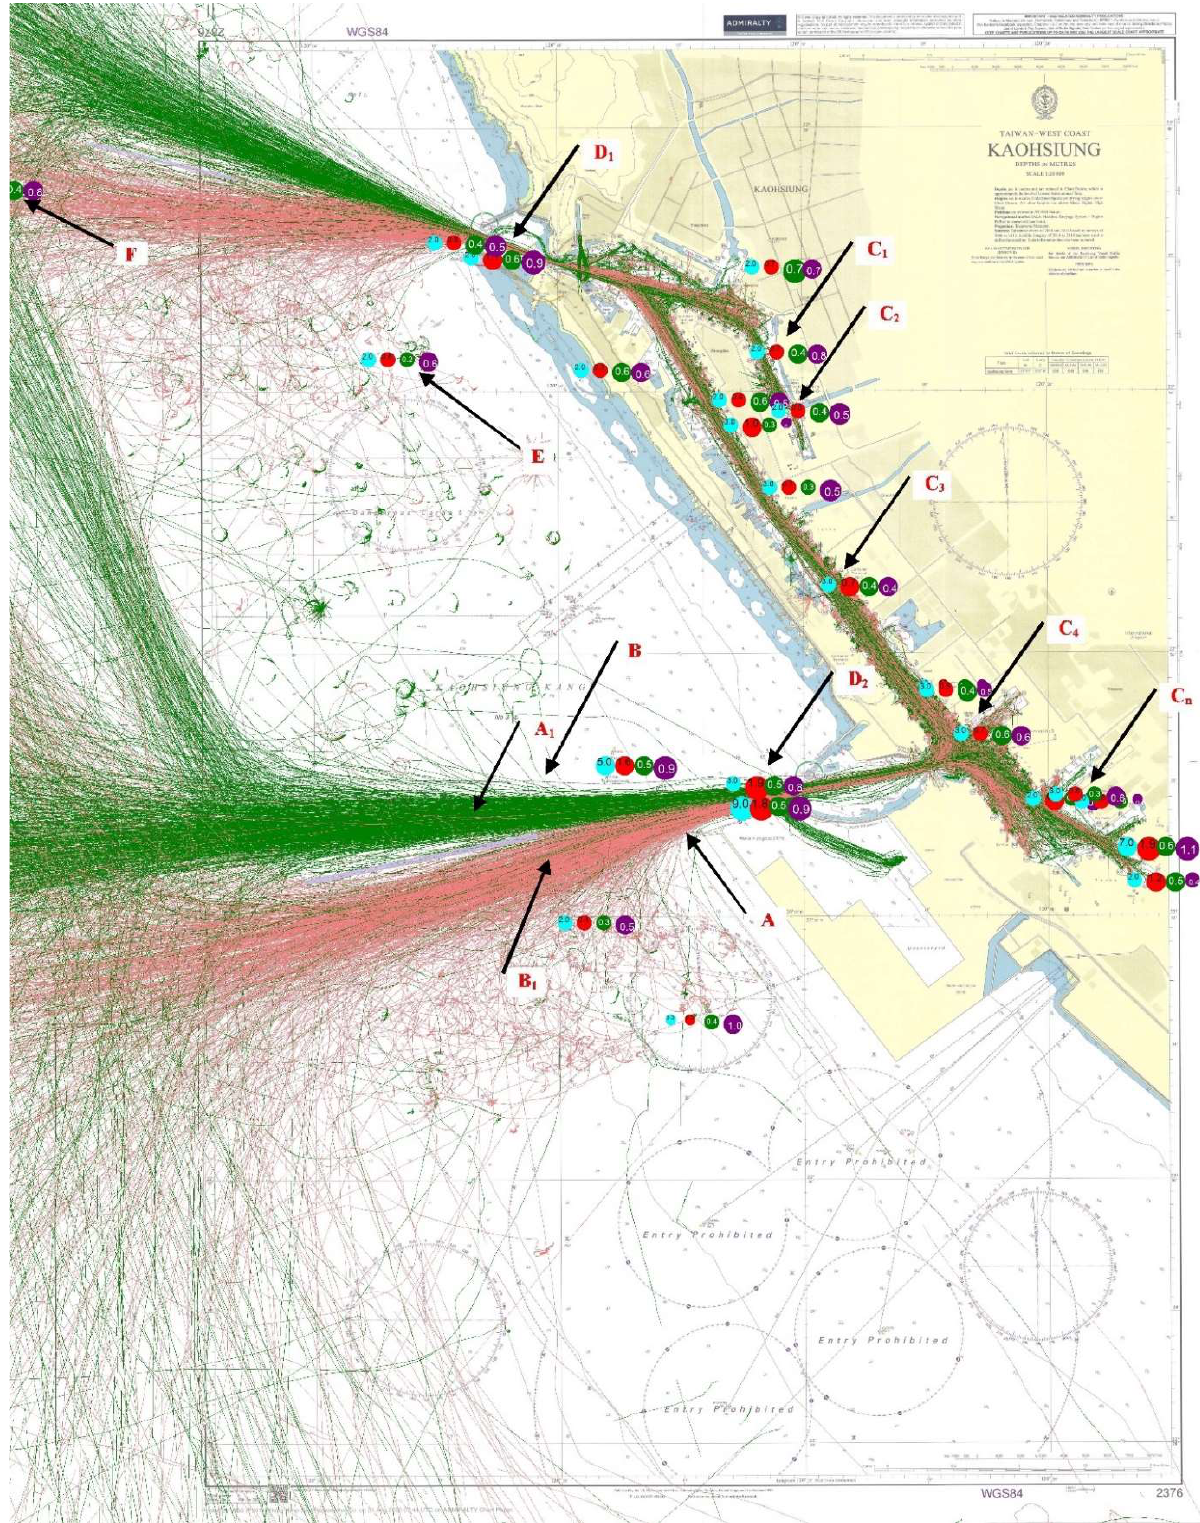
Figure 9. All data for the port of Kaohsiung are integrated on the e-chart. Note: lines A, A 1 , B, and B 1 are traffic flows; points C 1 , C 2 , …, C n are marine accidents within the port; points D 1 and D 2 are marine accidents in the channel; point E is the marine accident in the anchorage; a set of data (four circles including blue, red, green, and purple circles) means one marine accident, and the position of the blue circle is the location of that marine accident.